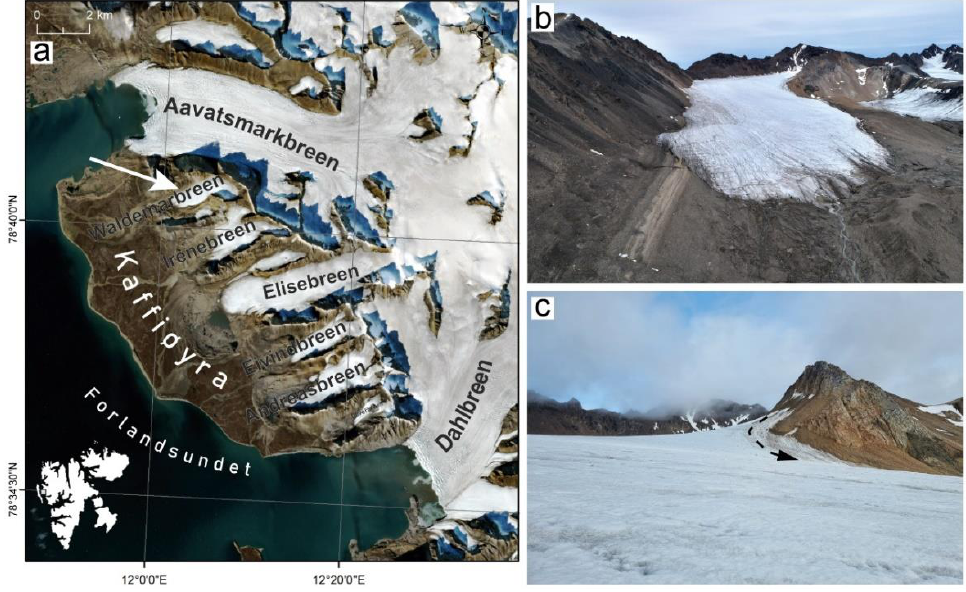
Figure 1. ( a ) The location of Waldemarbreen in north-western Spitsbergen (white arrow); ( b ) A view towards Waldemarbreen taken by UAV in August 2021; ( c ) the direction of ice flow (black arrow) at the steep glacier slope.